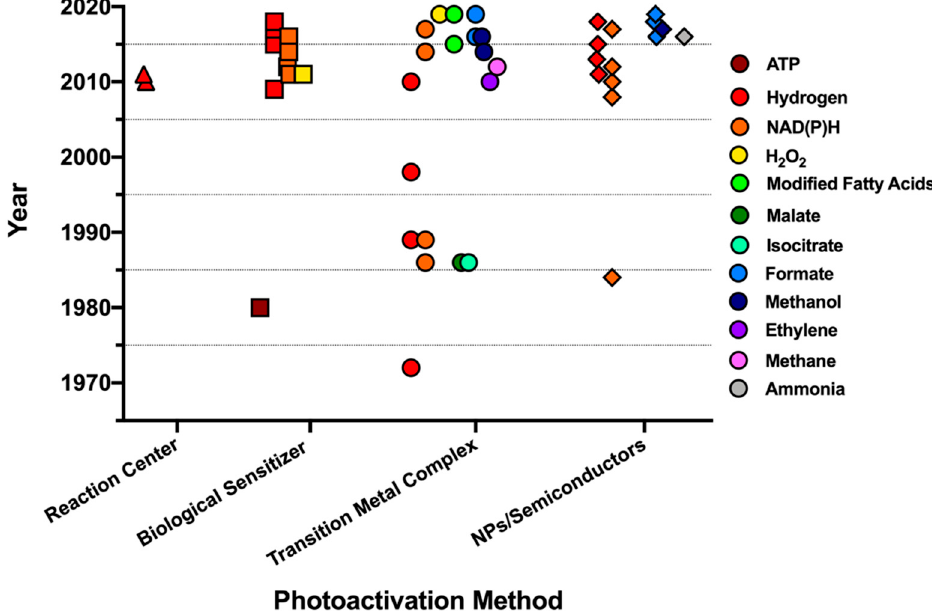
Figure 6. Timeline of selected biohybrid artificial photosynthetic studies. This has been organized by light active material and targeted catalytic product. Chemical products are color coded and separated by photoactivation